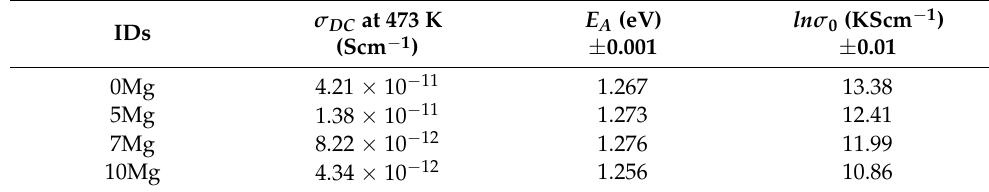
Figure 4. ( a ) The real part of AC conductivity versus frequency presented for different tempera- tures for sample 10Mg and ( b ) DC conductivity versus reciprocal temperature for all samples. The symbol size included error bars. Table 3. Values of DC conductivity estimated at 473 K, activation energy of DC conduction process and σ 0